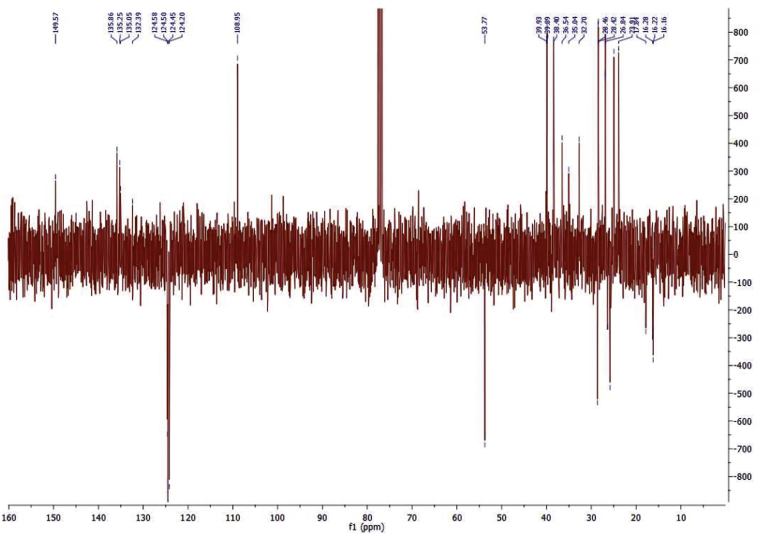
13C NMR spectrum (APT) of 3-deoxyachilleol in CDCl3.